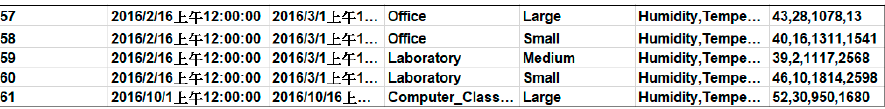
Figure 19. Output in the trimming step.